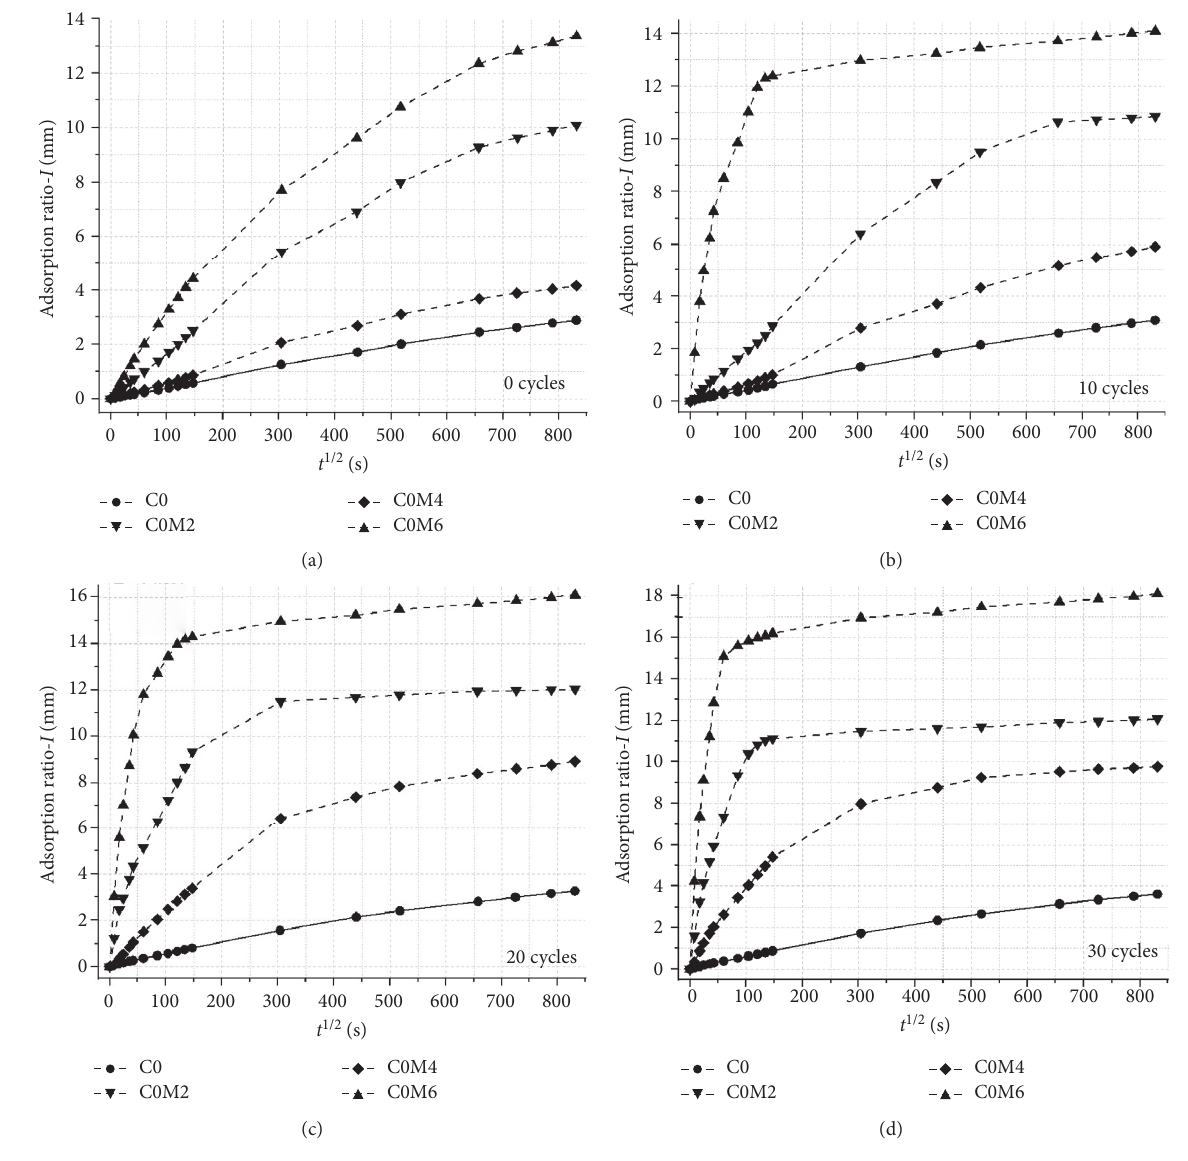
Figure 2: I − t 1/2 curve. Table 4: Water absorption ratio ω of saturated coarse